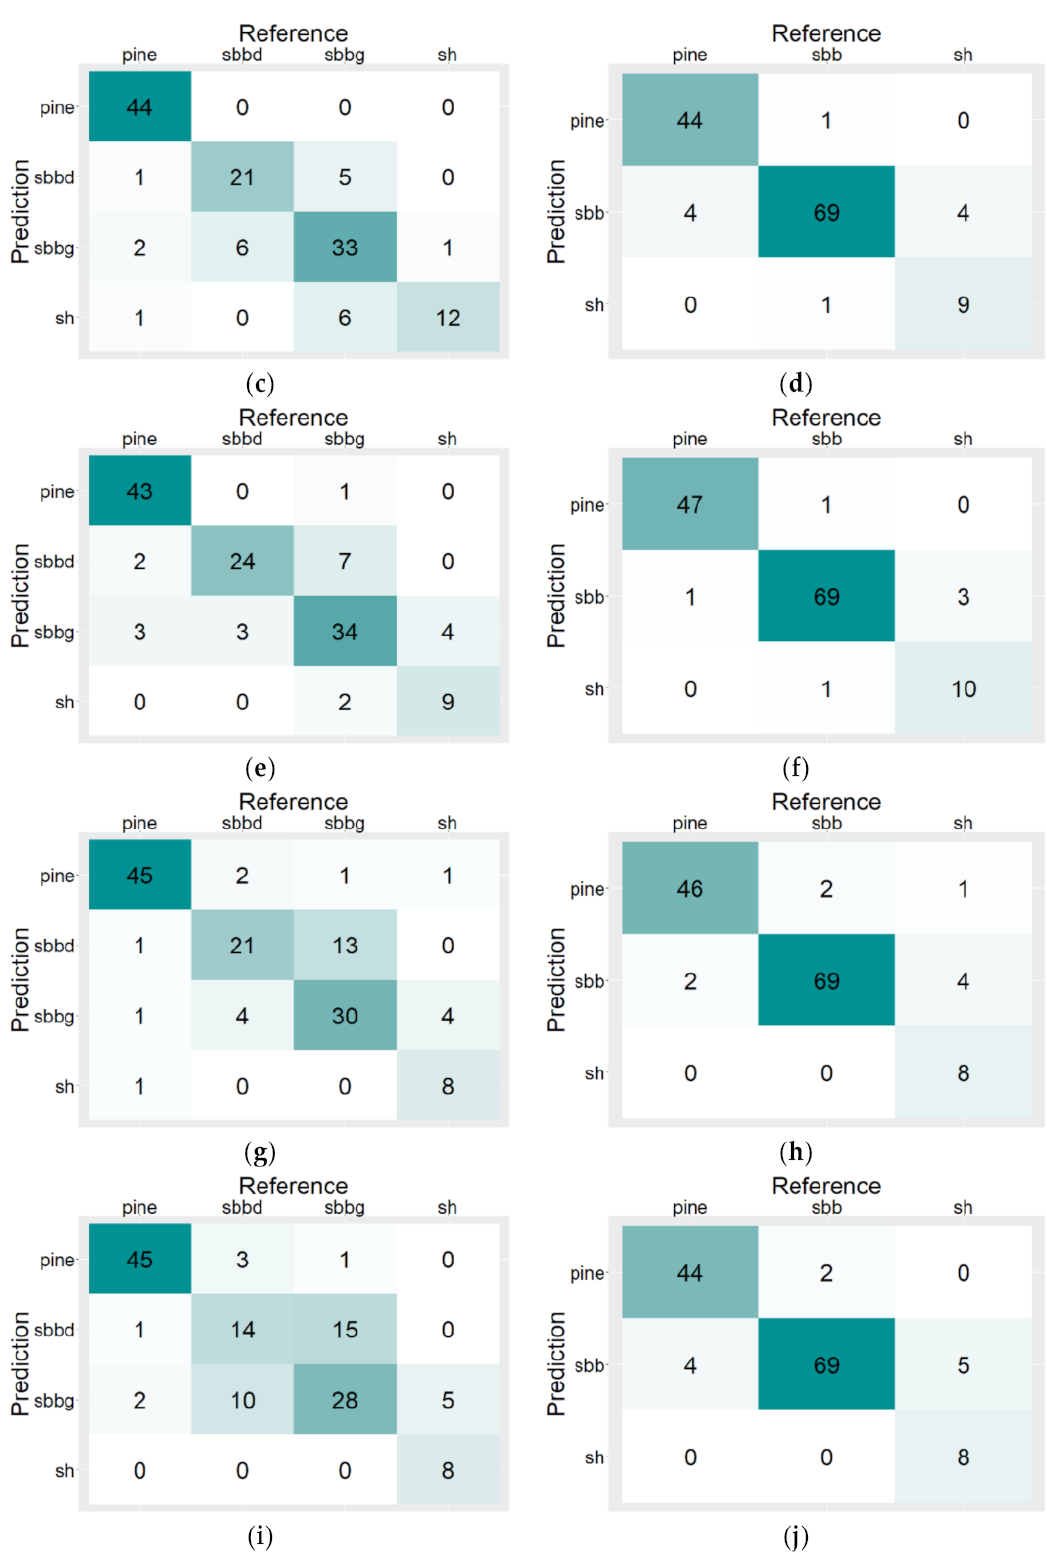
Figure 4. Confusion matrices of the best performing models classifying trees into four classes (left column) or three classes (right column) according to Table 5: ( a ) Nez 4c3b; ( b ) Nez 3c3b; ( c ) Saf 4c3b; ( d ) Saf 3c3b; ( e ) Safaugu 4c3b; ( f ) Safaugu 3c3b; ( g ) Dense169 4c3b; ( h ) Dense 3c4b; ( i ) RF 4c4b; ( j ) RF